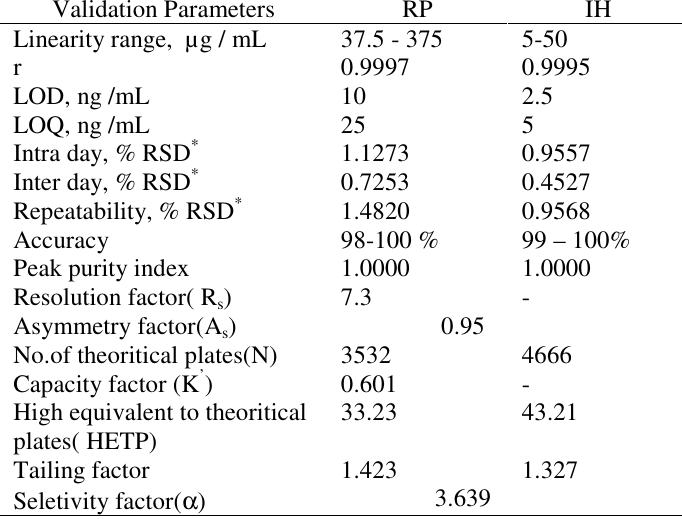
Table 2. System suitability & Validation parameters for